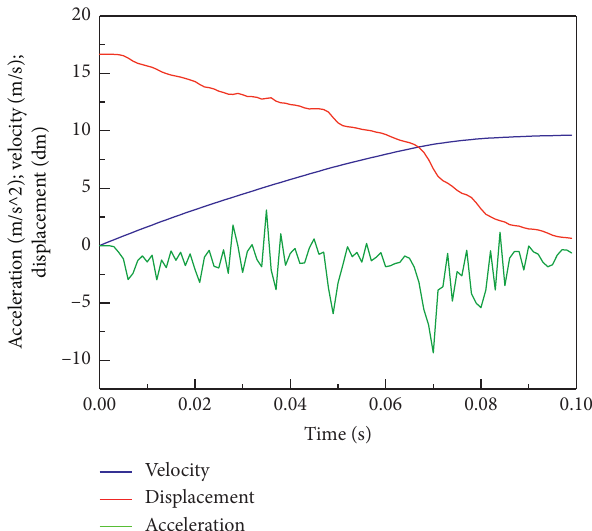
Figure 16: Results of the CLGAN model